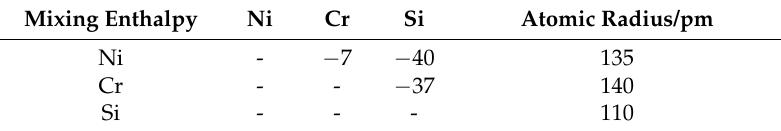
Table 2. Values of ∆ H mix radius.